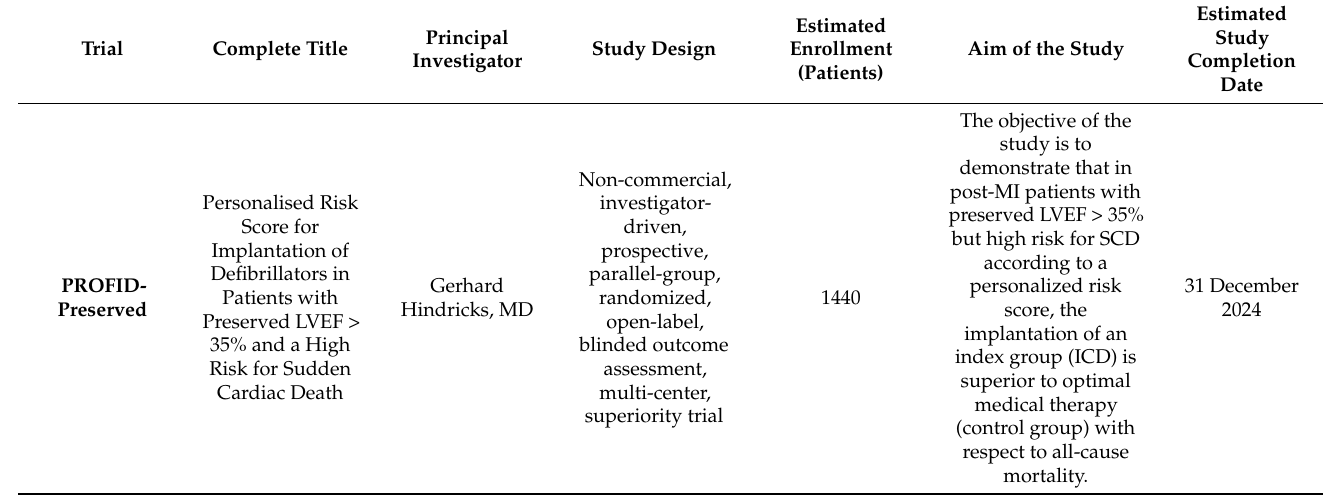
Table 2. Ongoing trials on sudden cardiac death in patients with preserved ejection